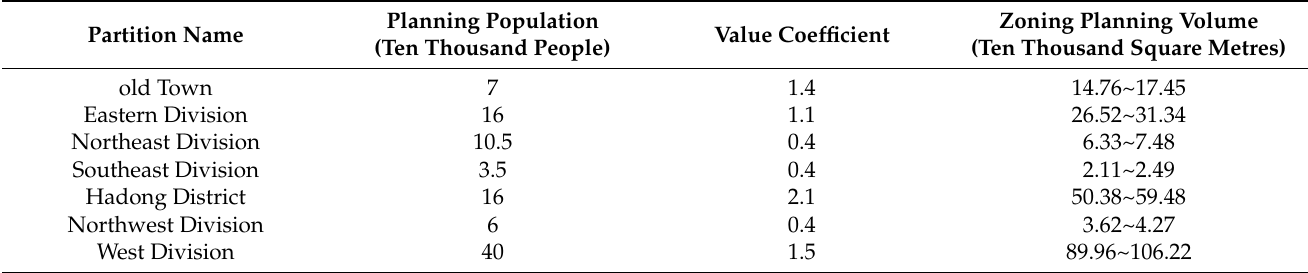
Table 15. Control of underground space planning volume in each